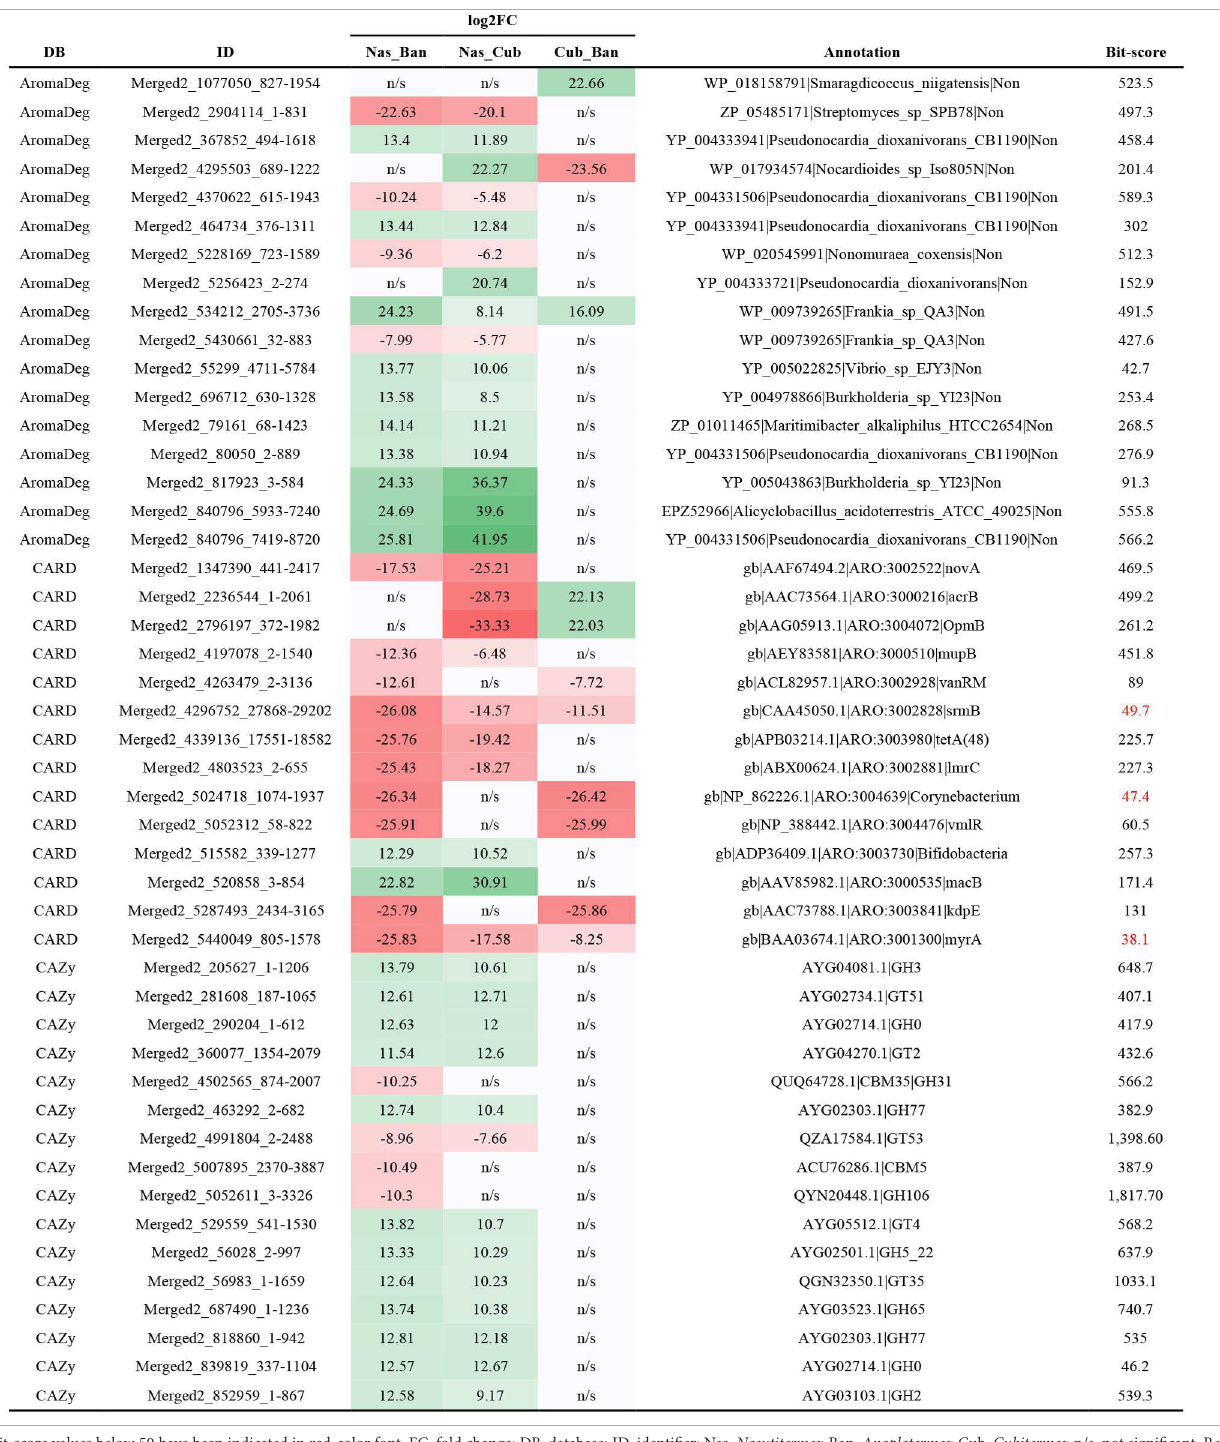
TABLE 4 Genes with differential presence obtained from the specific annotations with AromaDeg, CARD, and CAZy